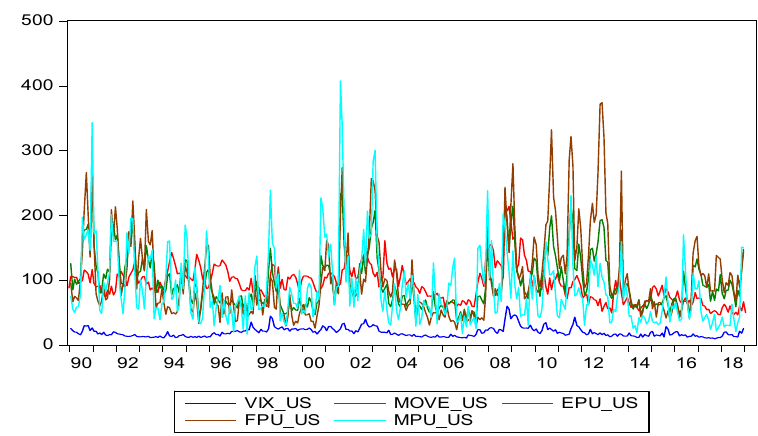
Figure 1. Time-varying VIX, MOVE, EPU, FPU, and MPU in the US market.